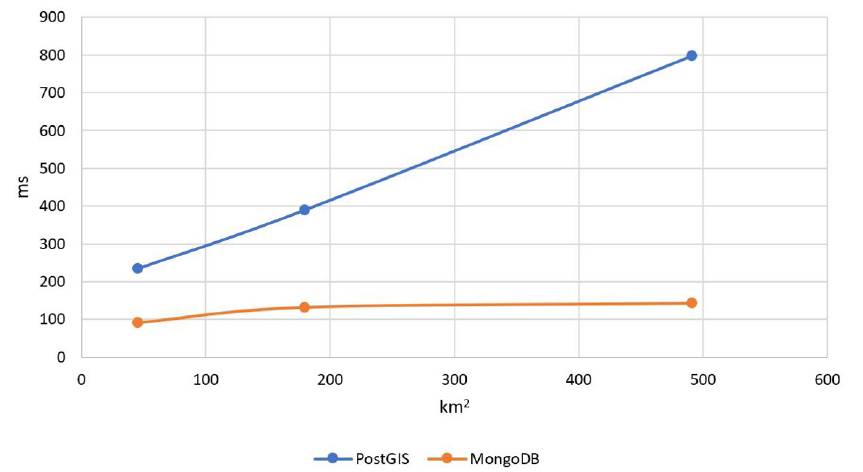
Fig. 4. The query execution time in dependence of the size of the search area for the Intersects